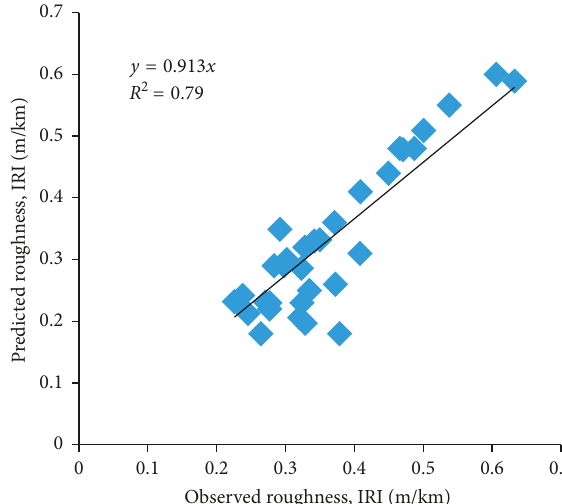
Figure 16: Scatter plot between observed versus predicted potholes for training.